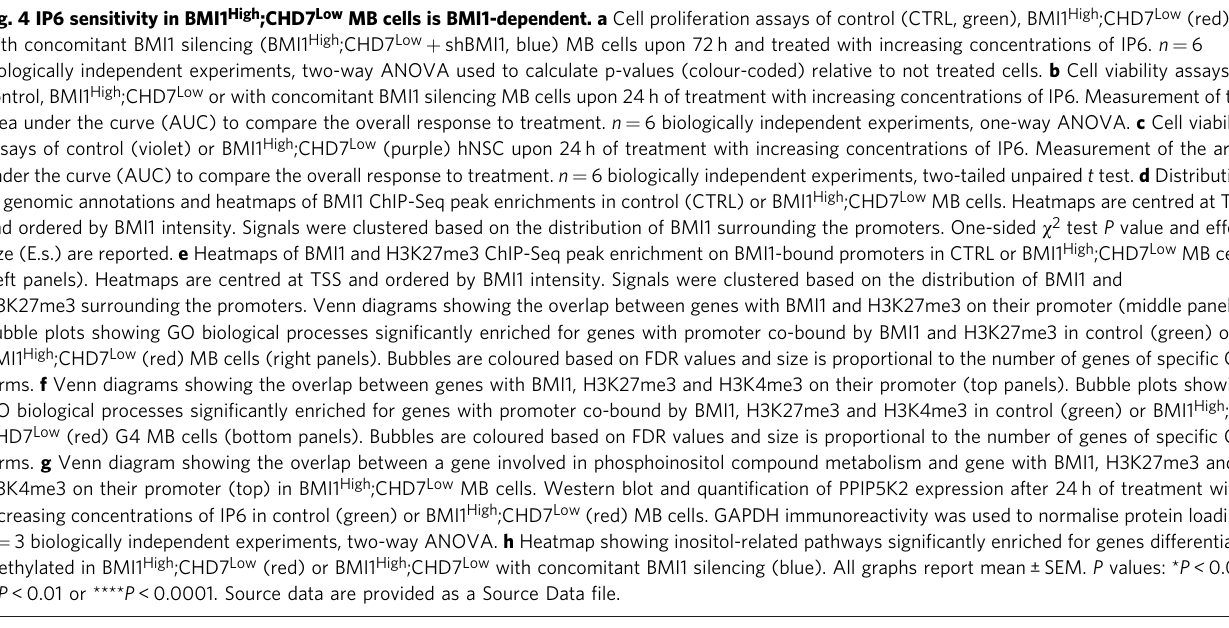
Fig. 4 IP6 sensitivity in BMI1 High ;CHD7 Low MB cells is BMI1-dependent. a Cell proliferation assays of control (CTRL, green), BMI1 High ;CHD7 Low (red) or with concomitant BMI1 silencing (BMI1 High ;CHD7 Low + shBMI1, blue) MB cells upon 72 h and treated with increasing concentrations of IP6. n = 6 biologically independent experiments, two-way ANOVA used to calculate p-values (colour-coded) relative to not treated cells. b Cell viability assays of control, BMI1 High ;CHD7 Low or with concomitant BMI1 silencing MB cells upon 24 h of treatment with increasing concentrations of IP6. Measurement of the area under the curve (AUC) to compare the overall response to treatment. n = 6 biologically independent experiments, one-way ANOVA. c Cell viability assays of control (violet) or BMI1 High ;CHD7 Low (purple) hNSC upon 24 h of treatment with increasing concentrations of IP6. Measurement of the area under the curve (AUC) to compare the overall response to treatment. n = 6 biologically independent experiments, two-tailed unpaired t test. d Distribution of genomic annotations and heatmaps of BMI1 ChIP-Seq peak enrichments in control (CTRL) or BMI1 High ;CHD7 Low MB cells. Heatmaps are centred at TSS and ordered by BMI1 intensity. Signals were clustered based on the distribution of BMI1 surrounding the promoters. One-sided χ 2 test P value and effect size (E.s.) are reported. e Heatmaps of BMI1 and H3K27me3 ChIP-Seq peak enrichment on BMI1-bound promoters in CTRL or BMI1 High ;CHD7 Low MB cells (left panels). Heatmaps are centred at TSS and ordered by BMI1 intensity. Signals were clustered based on the distribution of BMI1 and H3K27me3 surrounding the promoters. Venn diagrams showing the overlap between genes with BMI1 and H3K27me3 on their promoter (middle panels). Bubble plots showing GO biological processes signi fi cantly enriched for genes with promoter co-bound by BMI1 and H3K27me3 in control (green) or BMI1 High ;CHD7 Low (red) MB cells (right panels). Bubbles are coloured based on FDR values and size is proportional to the number of genes of speci fi c GO terms. f Venn diagrams showing the overlap between genes with BMI1, H3K27me3 and H3K4me3 on their promoter (top panels). Bubble plots showing GO biological processes signi fi cantly enriched for genes with promoter co-bound by BMI1, H3K27me3 and H3K4me3 in control (green) or BMI1 High ; CHD7 Low (red) G4 MB cells (bottom panels). Bubbles are coloured based on FDR values and size is proportional to the number of genes of speci fi c GO terms. g Venn diagram showing the overlap between a gene involved in phosphoinositol compound metabolism and gene with BMI1, H3K27me3 and H3K4me3 on their promoter (top) in BMI1 High ;CHD7 Low MB cells. Western blot and quanti fi cation of PPIP5K2 expression after 24 h of treatment with increasing concentrations of IP6 in control (green) or BMI1 High ;CHD7 Low (red) MB cells. GAPDH immunoreactivity was used to normalise protein loading. n = 3 biologically independent experiments, two-way ANOVA. h Heatmap showing inositol-related pathways signi fi cantly enriched for genes differentially methylated in BMI1 High ;CHD7 Low (red) or BMI1 High ;CHD7 Low with concomitant BMI1 silencing (blue). All graphs report mean ± SEM. P values: * P < 0.05, ** P < 0.01 or **** P < 0.0001. Source data are provided as a Source Data fi